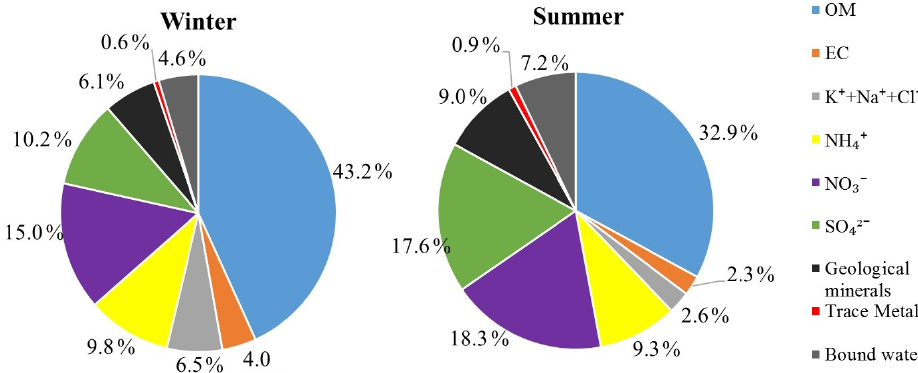
Figure 2. Chemical components of reconstructed PM 2 . 5 (offline) applying mass closure